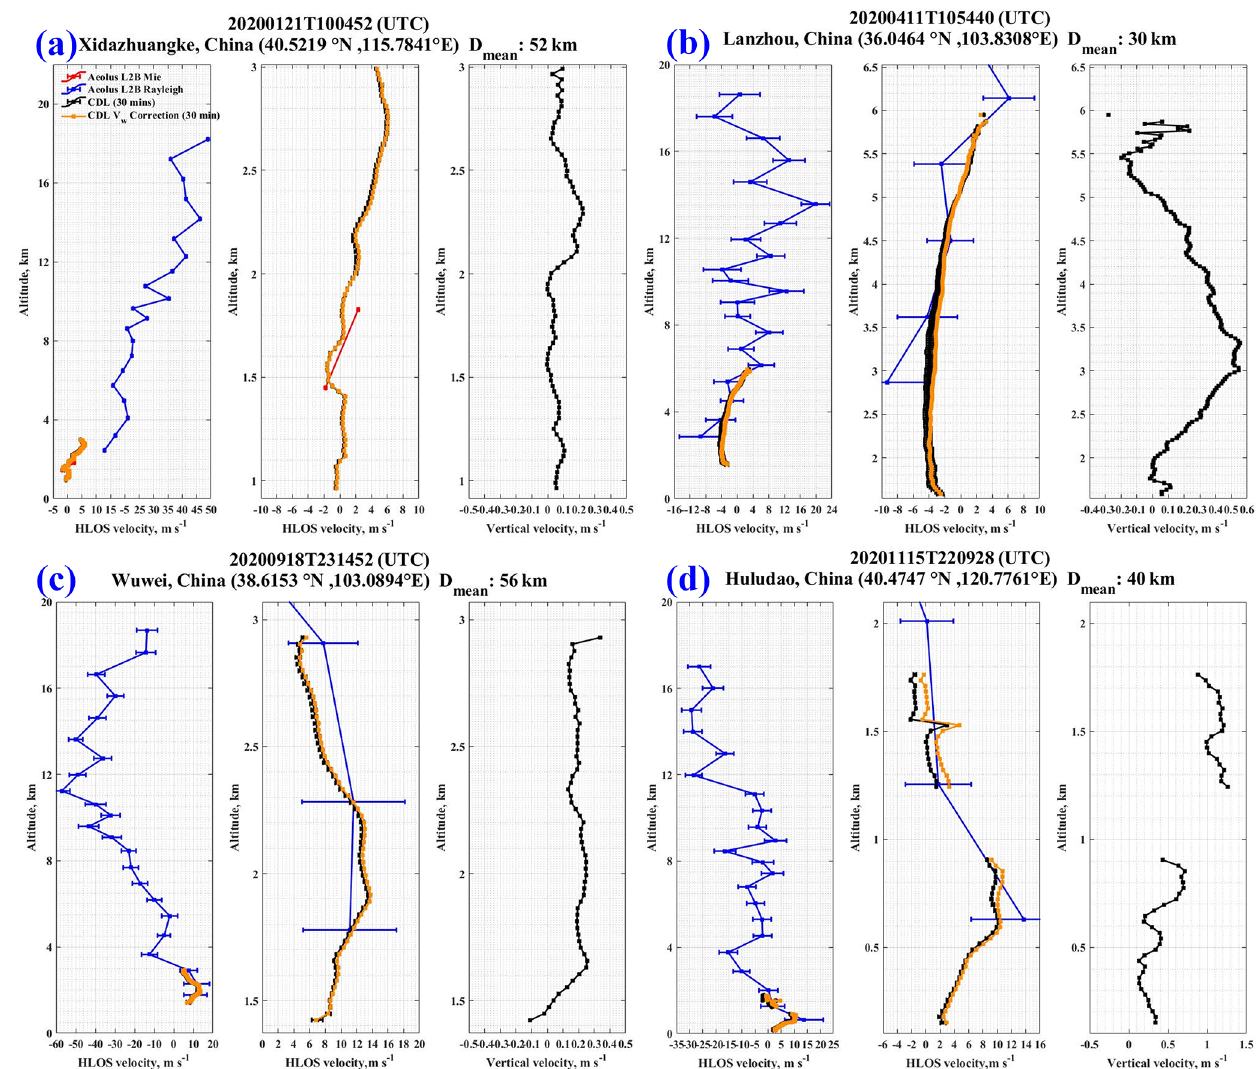
Figure 8. Inter-comparison of HLOS wind velocities measured with CDLs and Aeolus at (a) Xidazhuangke (Beijing), (b) Lanzhou (Gansu Province), (c) Wuwei (Gansu Province) and (d) Huludao (Liaoning Province) on 21 January, 11 April, 18 September and 15 November 2020, respectively. The lines are the same as those of Fig.